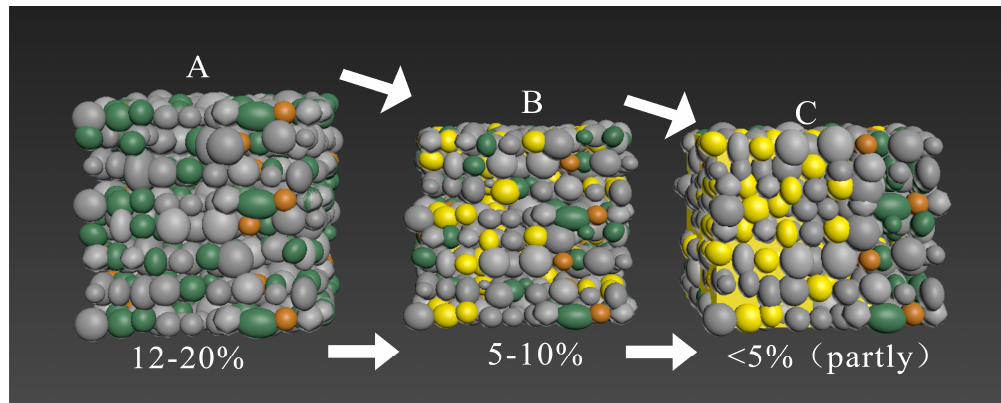
Figure 9. 3D evaluation model of lithic quartz sandstone. ( A ) the 3D Model of Figure 8B with the porosity ranging from 12–20%; ( B ) the 3D Model of Figure 8D with the porosity ranging from 5–10%; ( C ) the 3D Model of Figure 8F with the porosity less than 5%.